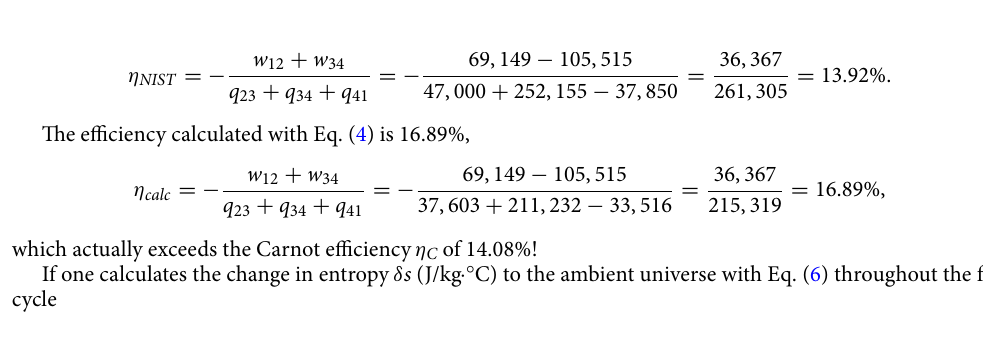
Table 2. The pressures and specific internal energies versus the density ρ , taken from NIST 54 , and used to solve the work and heat inputs and outputs listed in Table 1. The pressure P L (MPa) and specific internal energy u L (kJ/kg) is at 32 ◦ C, and the pressure P H (MPa) and specific internal energy u H (kJ/kg) is at 82 ◦ C.